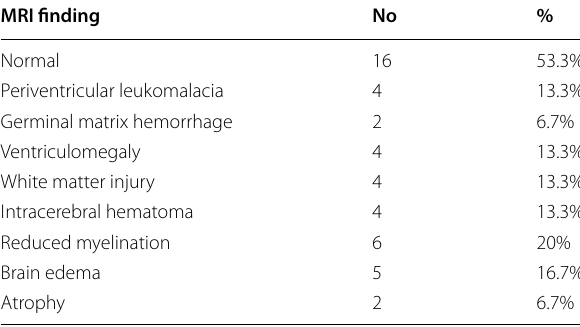
Table 1 MRI findings in the studied patients MRI finding